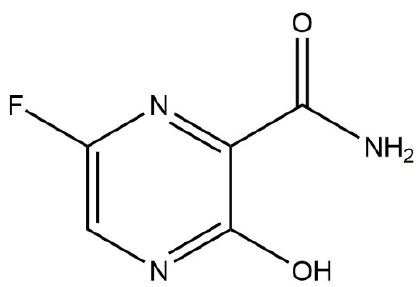
Figure 1. Structure of favipiravir.